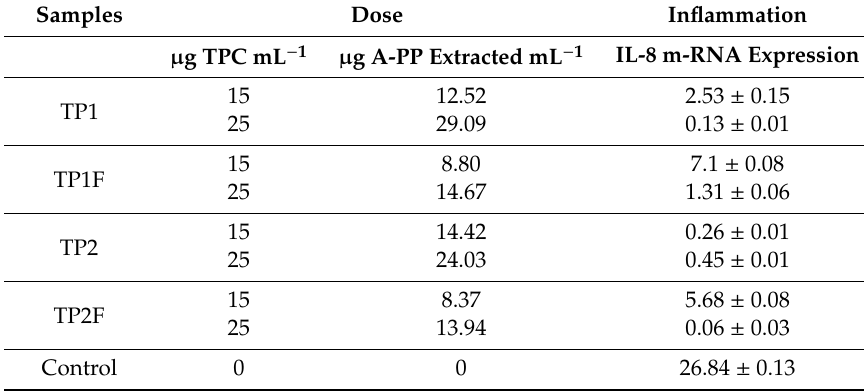
Table 4. E ff ect of TP extracts on IL-8 release from Caco-2